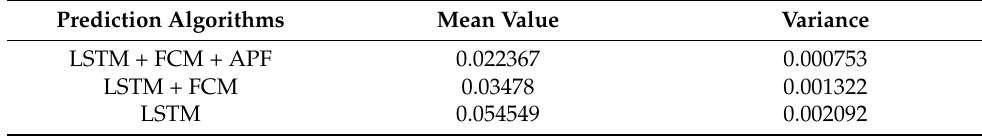
Table 3. The 5 − step of the lateral coordinate prediction results.